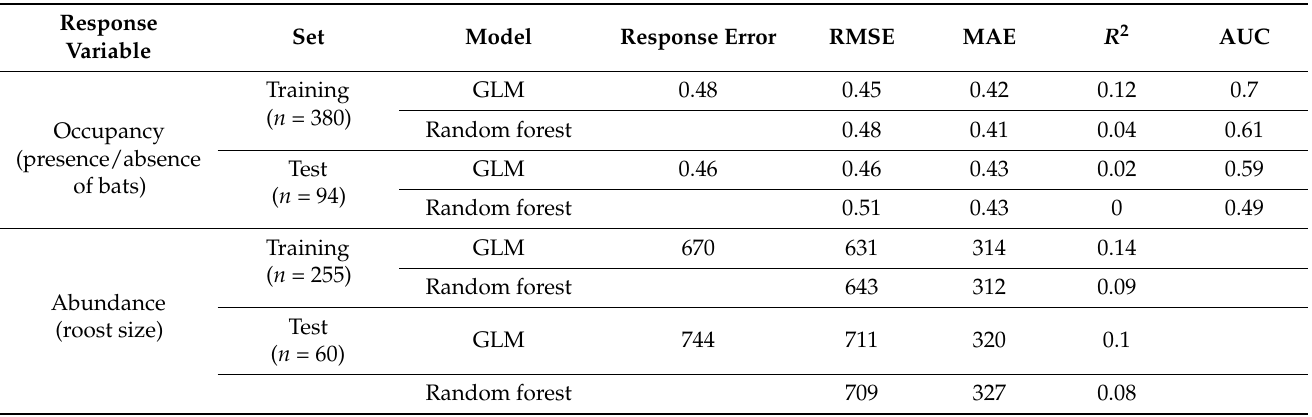
Table 1. Performance metrics of generalized linear models (GLMs) and random forests of bat roost occupancy and abundance.